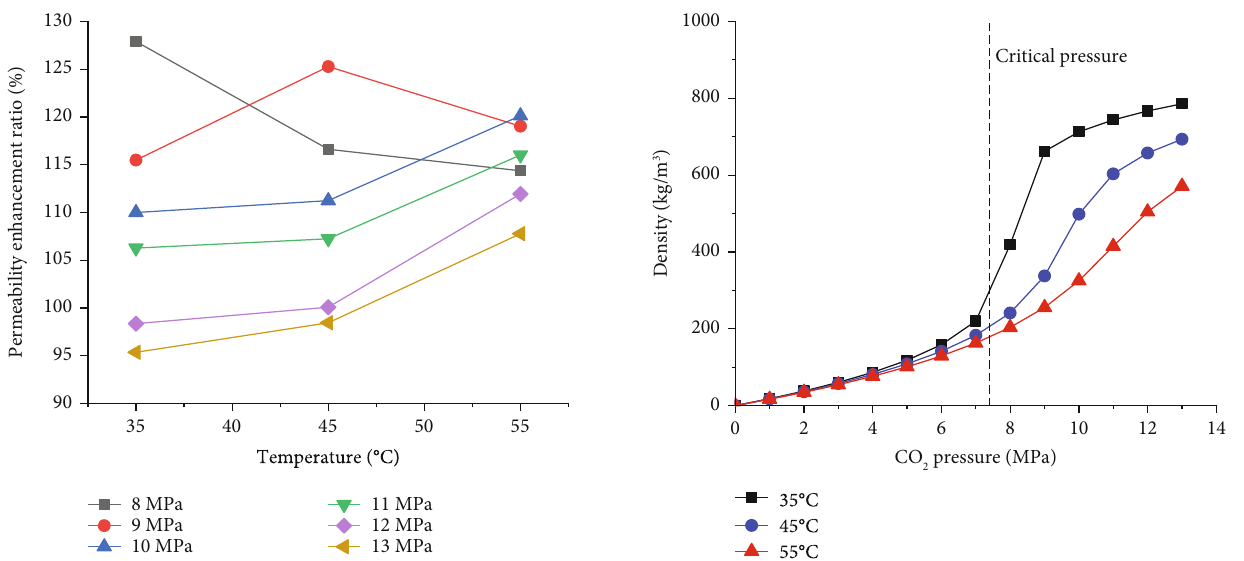
Figure 4: Permeability enhancement ratio with the increase of temperatures.